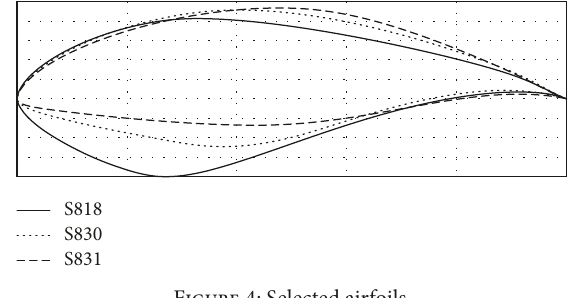
Figure 4: Selected airfoils. Table 4: Details of the modeled